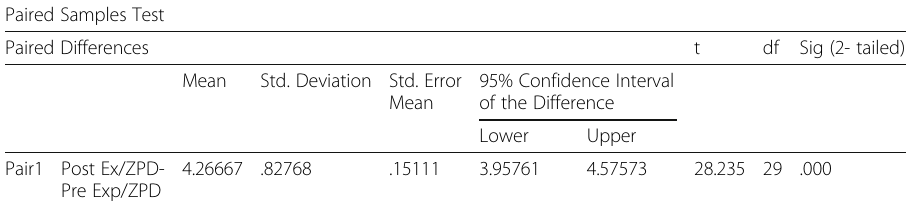
Table 8 Paired-Samples T-Test of the Experimental Group ’ s ZPD performance Paired Samples Test Paired